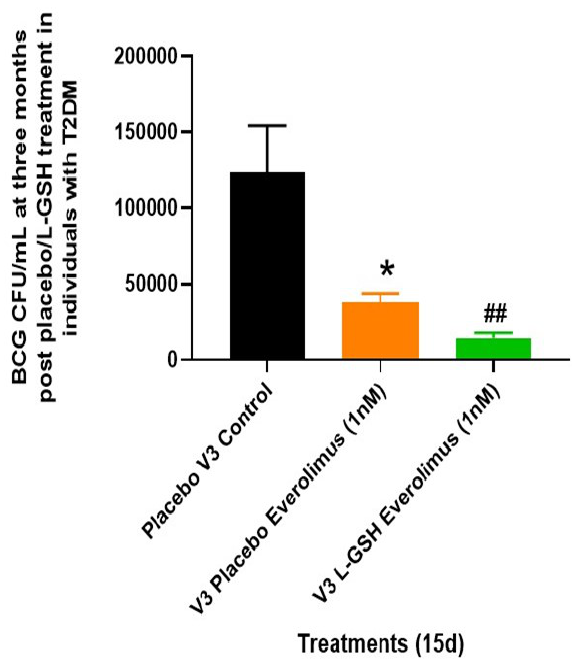
Figure 2: Clinical trial findings from in vivo and in vitro studies. Determination of BCG survival in the in vitro granulomas of T2DM subjects on L-GSH/ or placebo supplement. PBMCs isolated from individuals with type 2 diabetes at three months post- L-GSH/ or placebo supplementation were infected in vitro with BCG and treated in vitro with everolimus (1nM) and terminated at 15 days post-infection. The survival of BCG in the in vitro granulomas was determined by plating the granuloma lysates on 7H11